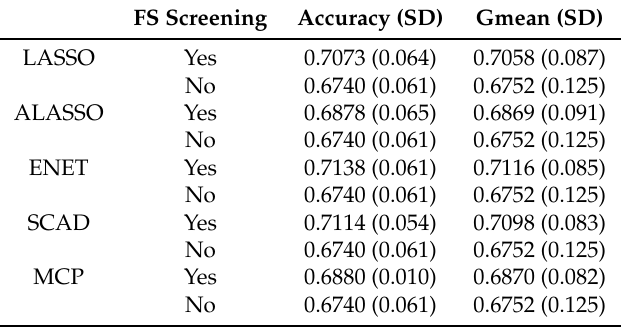
Table 4. Comparison of regularized regression models used in the ERRM with and without FS